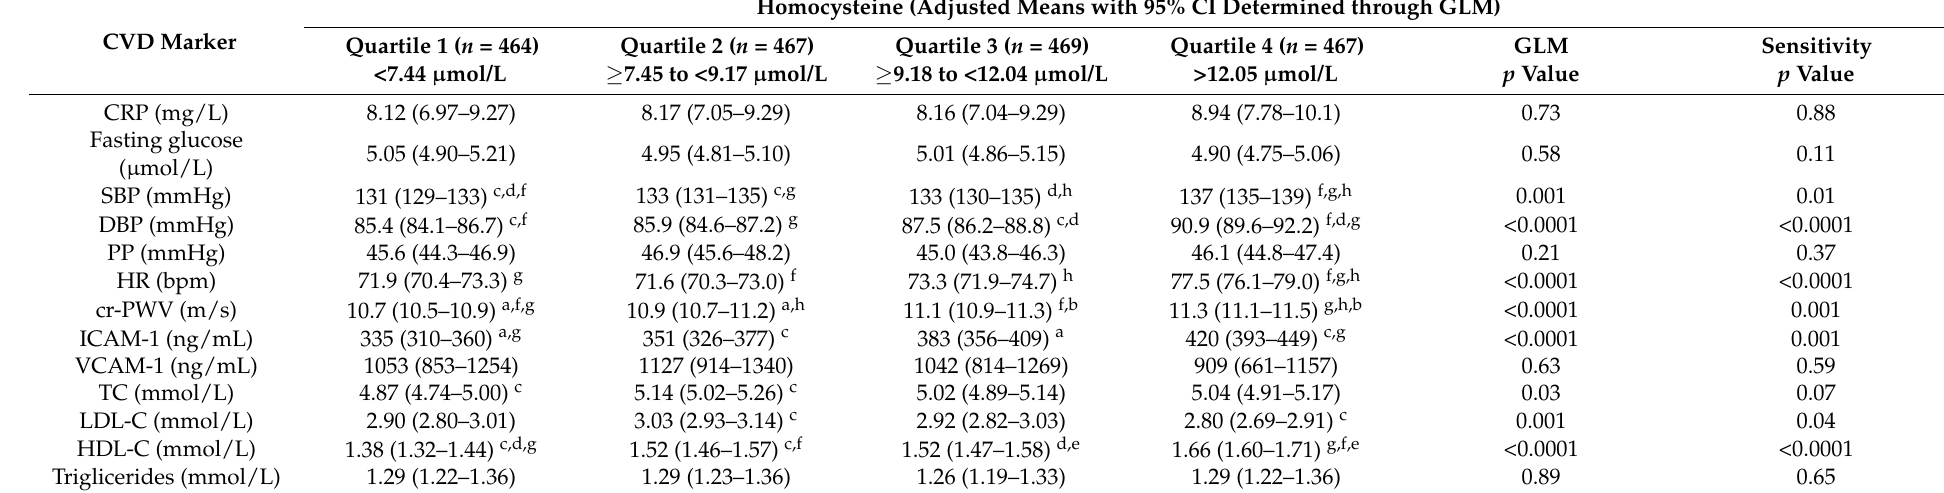
Table 4. Cardiovascular markers across Hcy